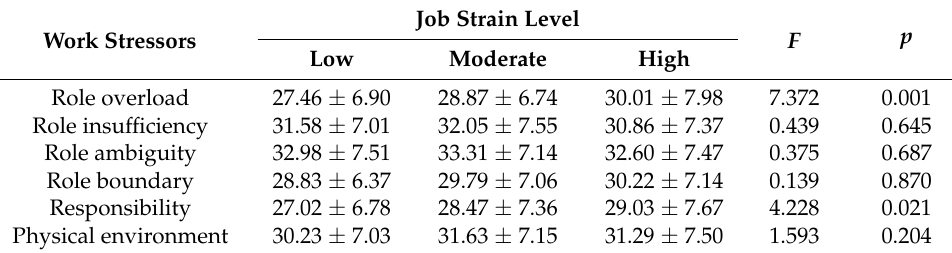
Table 2. Association between work stressors and job strain